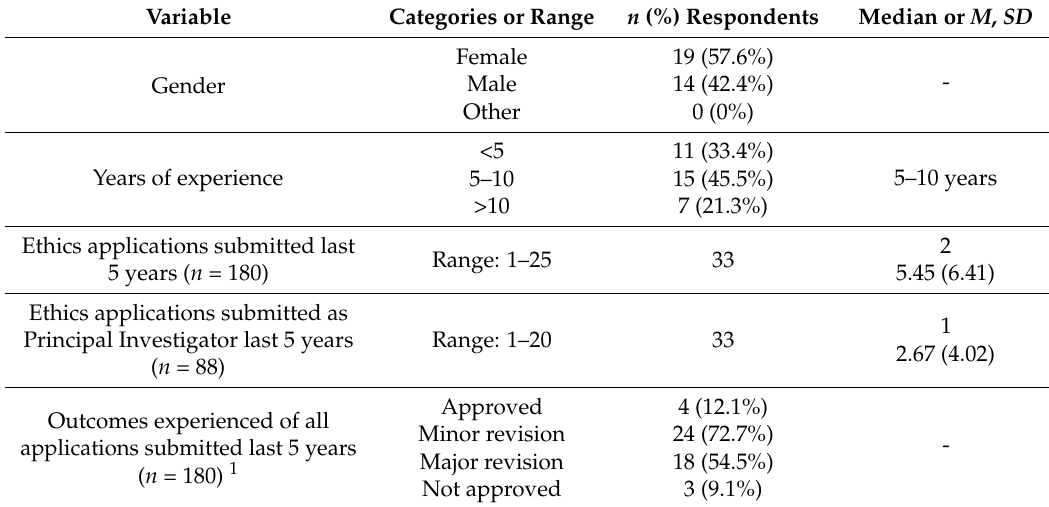
Table 1. Sample characteristics ( N =